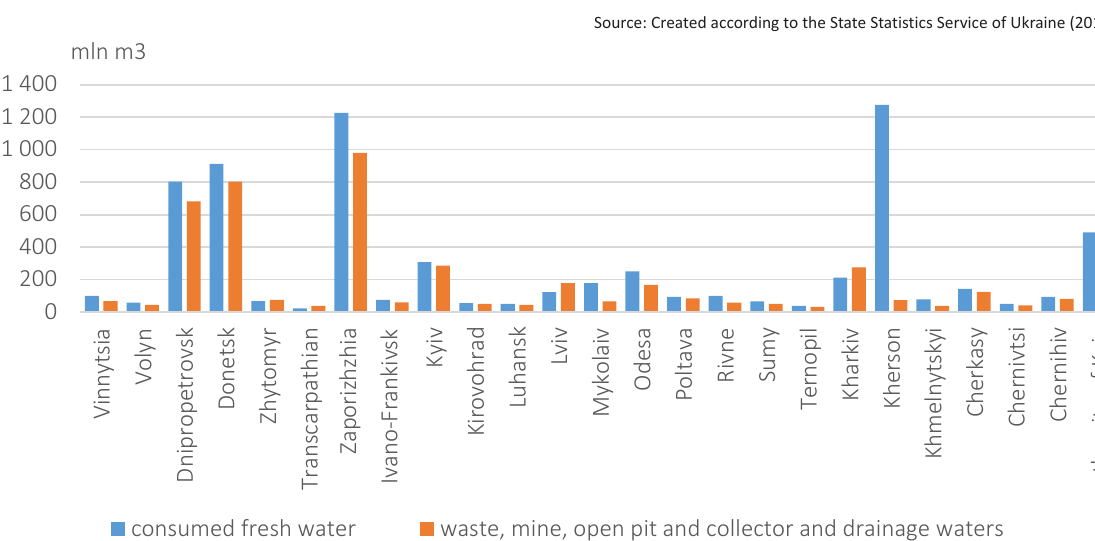
Figure 4. Total water consumption and drainage in 2017, mln m 3